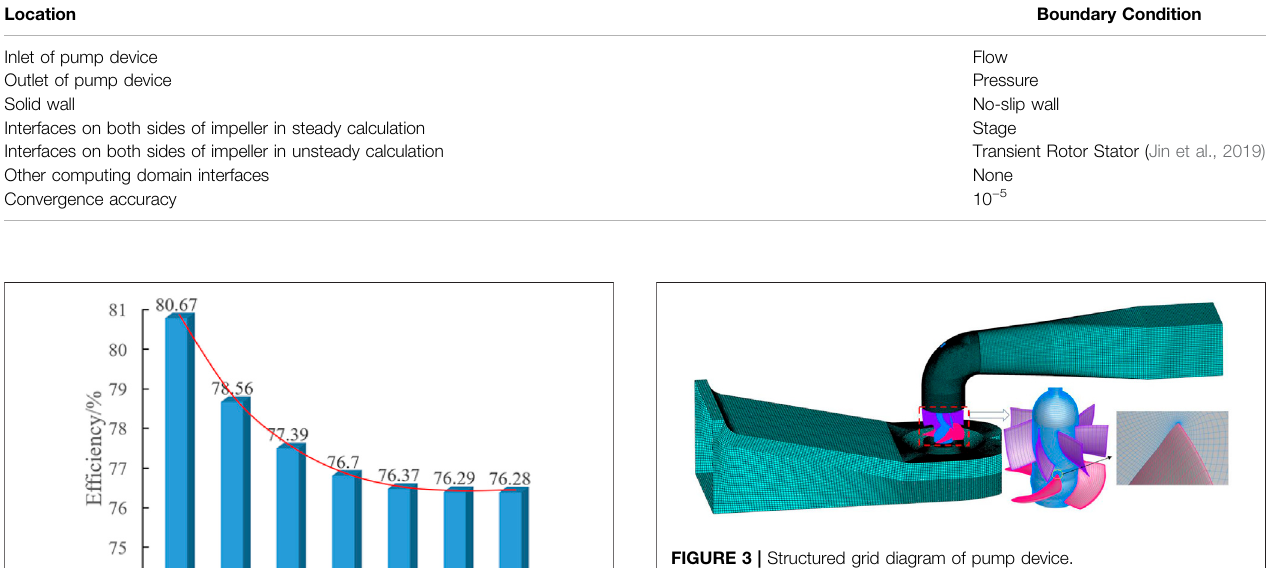
FIGURE 3 | Structured grid diagram of pump device.